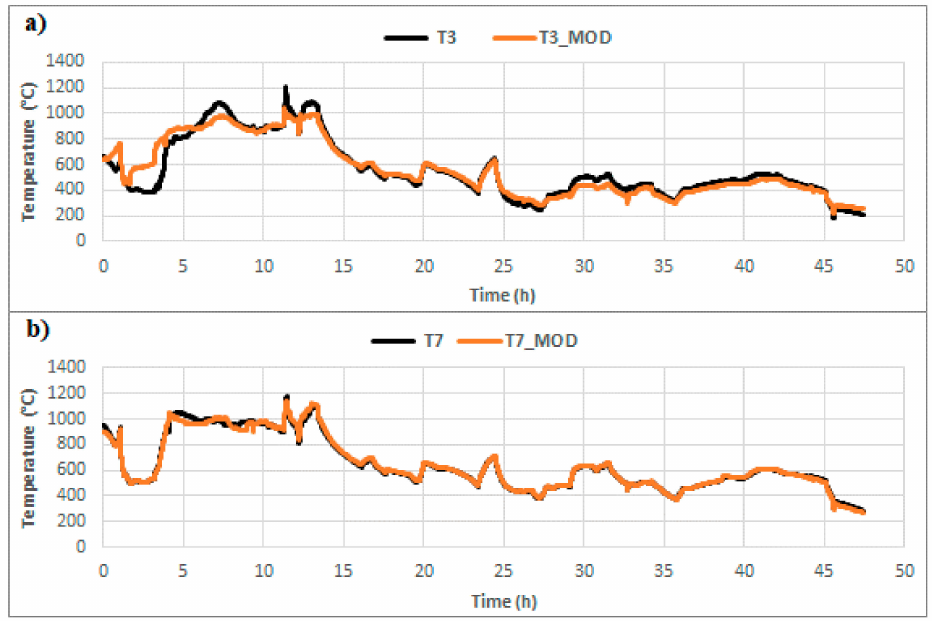
Figure 17. The measured (T) and modeled (T_MOD) temperature behavior, ( a ) temperature T 3 , ( b ) temperature T 7 (Source: own elaboration).